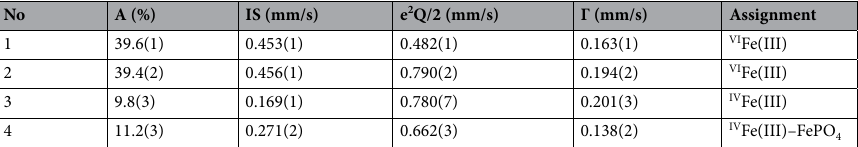
Table 1. Hyperfine interactions parameters (A—relative area, IS—isomer shift, e 2 Q/2—quadrupole split, Γ— half-width at half